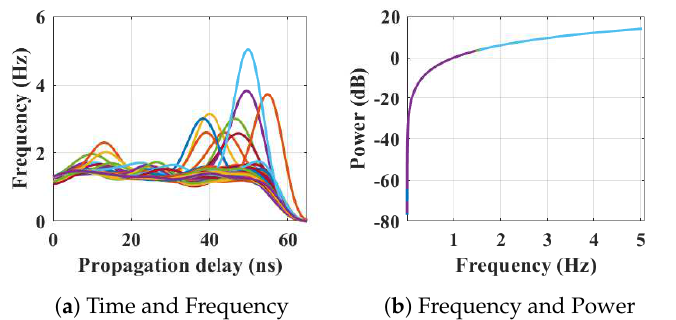
Figure 10. The relationship between propagation delay, activity frequency, and received power from the radar responses obtained while the person is walking from the kitchen through to the dining room and hallway entrance to living room has been considered as C7 in classification